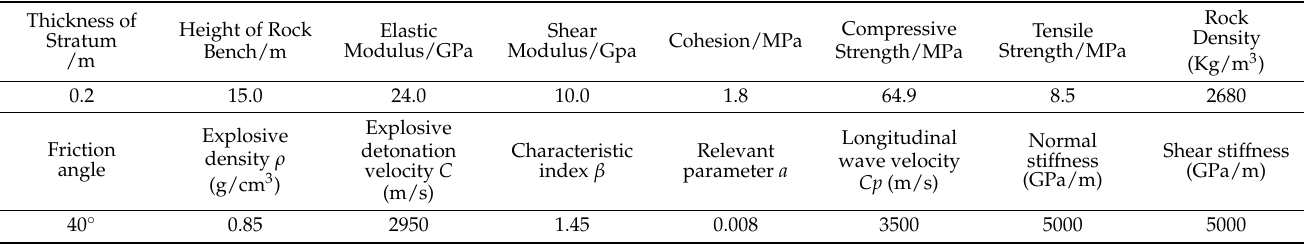
Table 1. Mechanical parameters of rock mass materials and model calculation